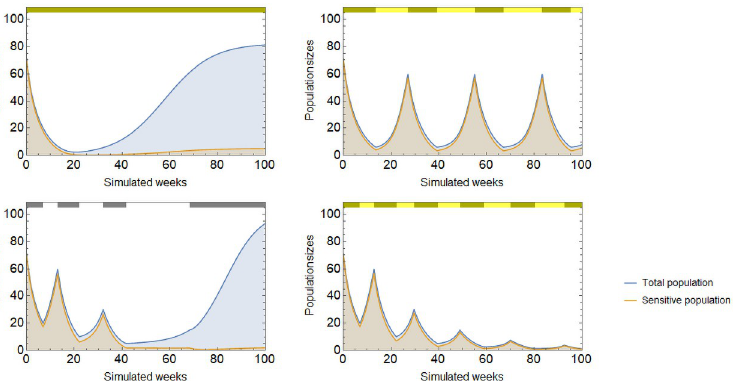
Fig 7. Mutation therapy together with cytotoxic therapy. Mutation therapy when applied with cytotoxic therapy improves therapy outcomes. Continuous cytotoxic therapy combined with mutation therapy delays coordination on the resistant type (top left). Adaptive cytotoxic therapy combined with mutation therapy may reach lower composition ( g = 32%) without losing control (top right). Therapy aimed at the extinction of the tumor fails without mutation therapy (bottom left) but succeeds with it (bottom right). Parameters: r 1 = 0.4, r 2 = 0.2, d 1 = d 2 = 0, K = 150, c 1 = c 2 = 0.05,